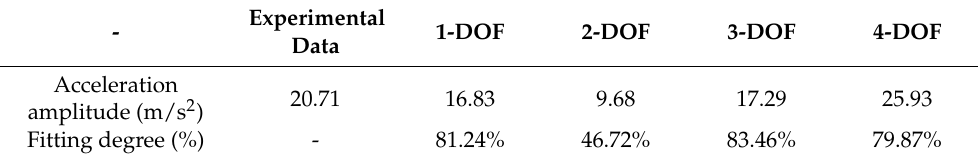
Table 5. Acceleration amplitude fitting of different simplified models.